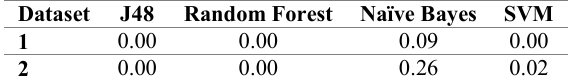
Table 8. Comparison of CPU time (seconds) taken for